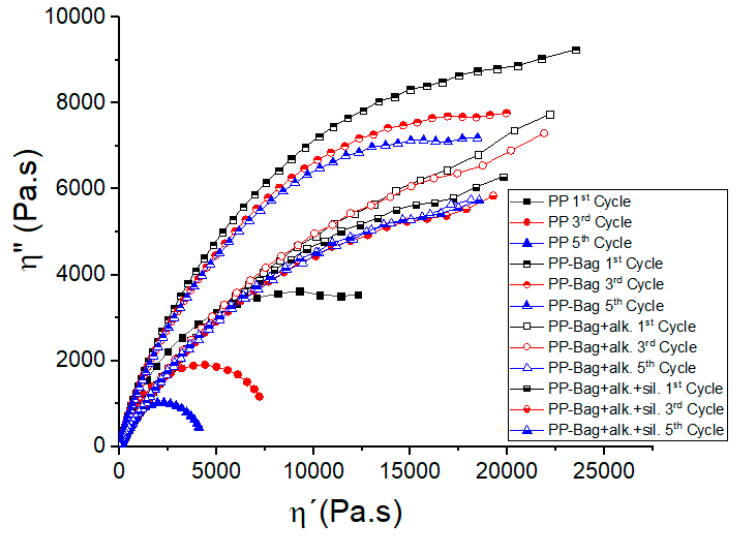
Figure 12. Cole–Cole plots of PP and PP-Bagasse biocomposites.